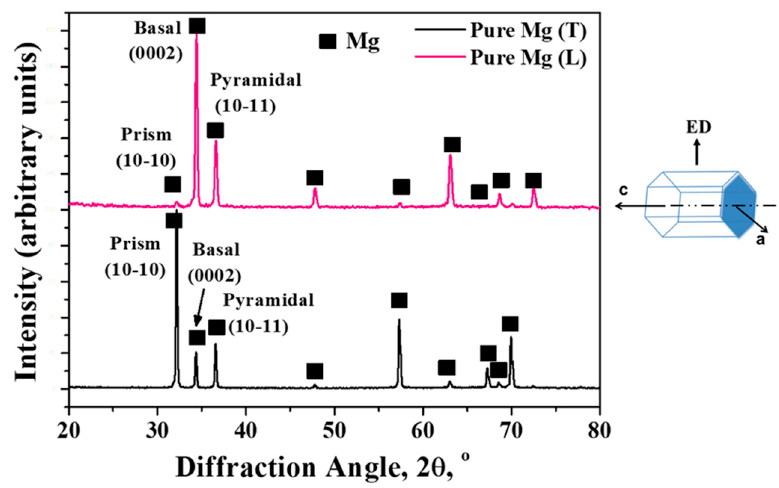
Figure 1. X-ray diffraction patterns of pure Mg along transverse and longitudinal sections.